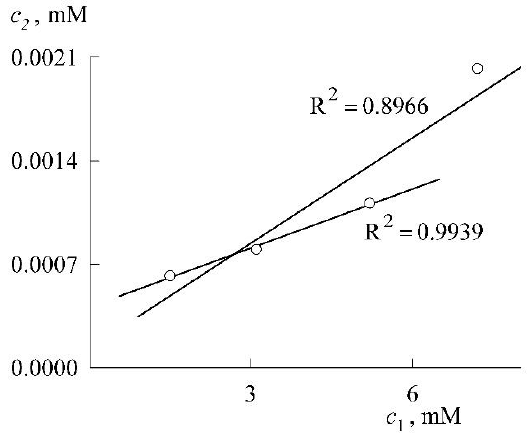
Figure 9. Verification of Equation (4).